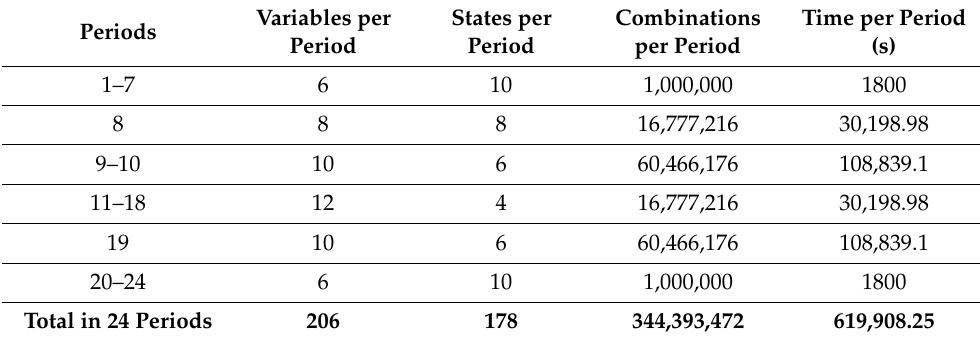
Table 3. Combinations, states, and expected simulation time with different number of